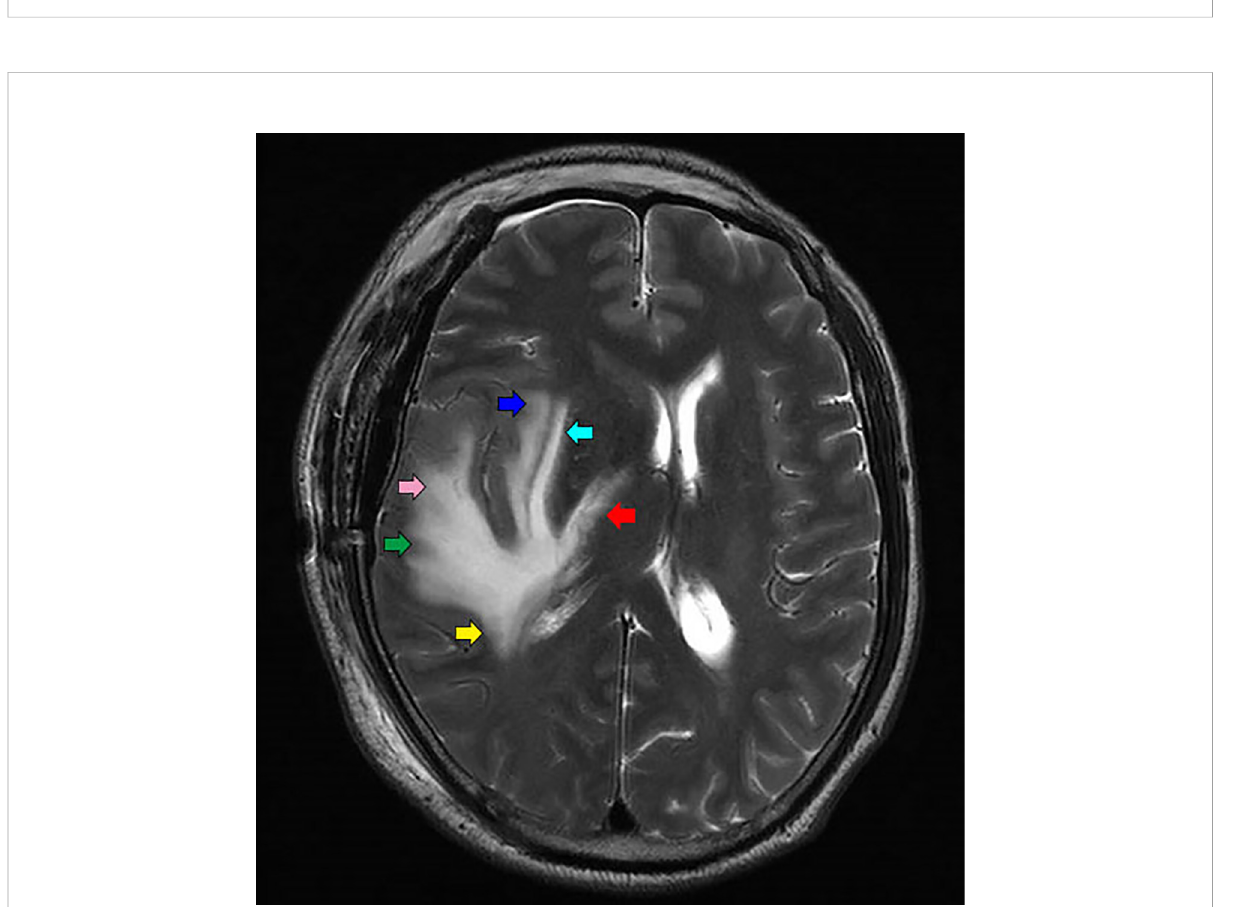
FIGURE 4 Recurrence-free survival of 66 study